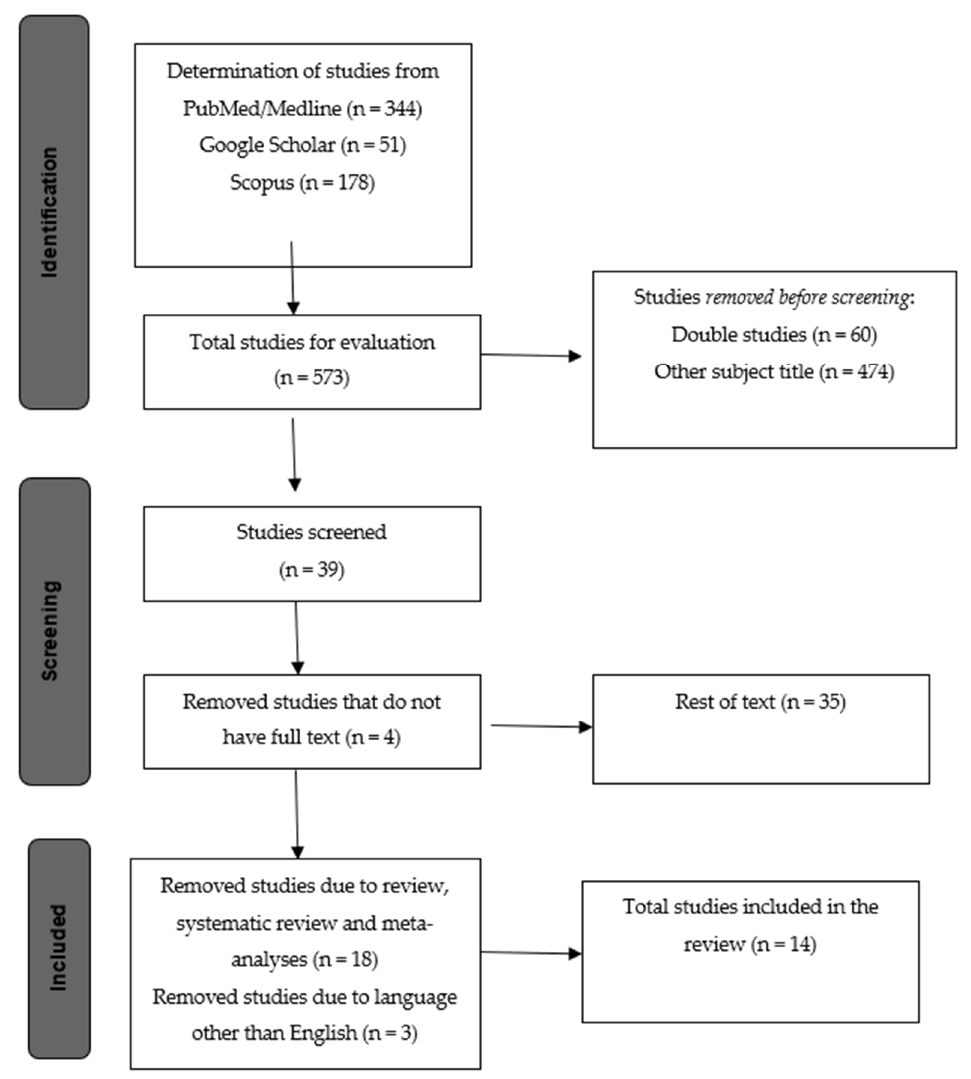
Figure 1. Flow chart: structure search strategy.